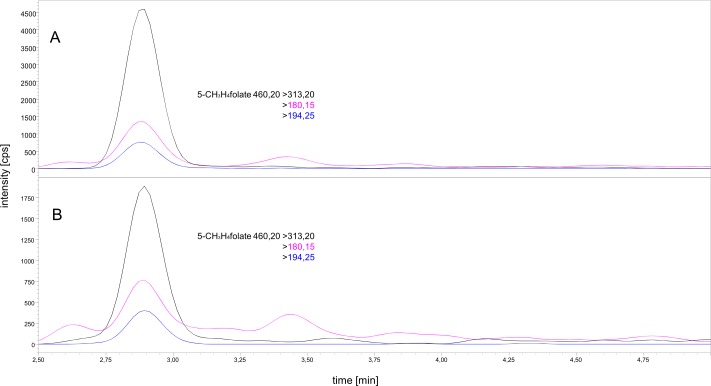
Comparison of extraction chromatograms of 60 μL (A) and 30 μL (B) of plasma; 5-CH3-H4folate m/z 460.20→313.20 (black), 460.20 → 180.15 (pink), and 460.20 → 194.25 (blue).